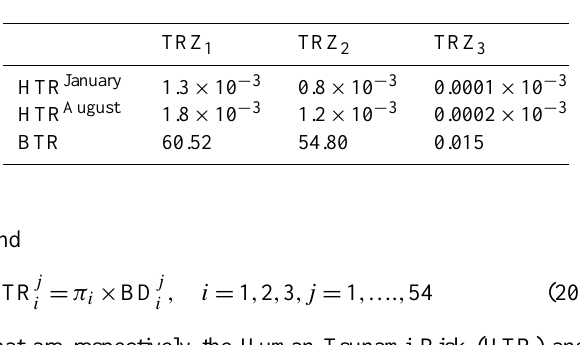
Fig. 6. Human Damage HD j in terms of number of persons (a) in January and (b) in August, and (c) Building Damage BD j i economic value (Euro) in each j -th section fraction in the i -th TRZ i ( j = 1 , 54 and i = 1 , 2 , 3).